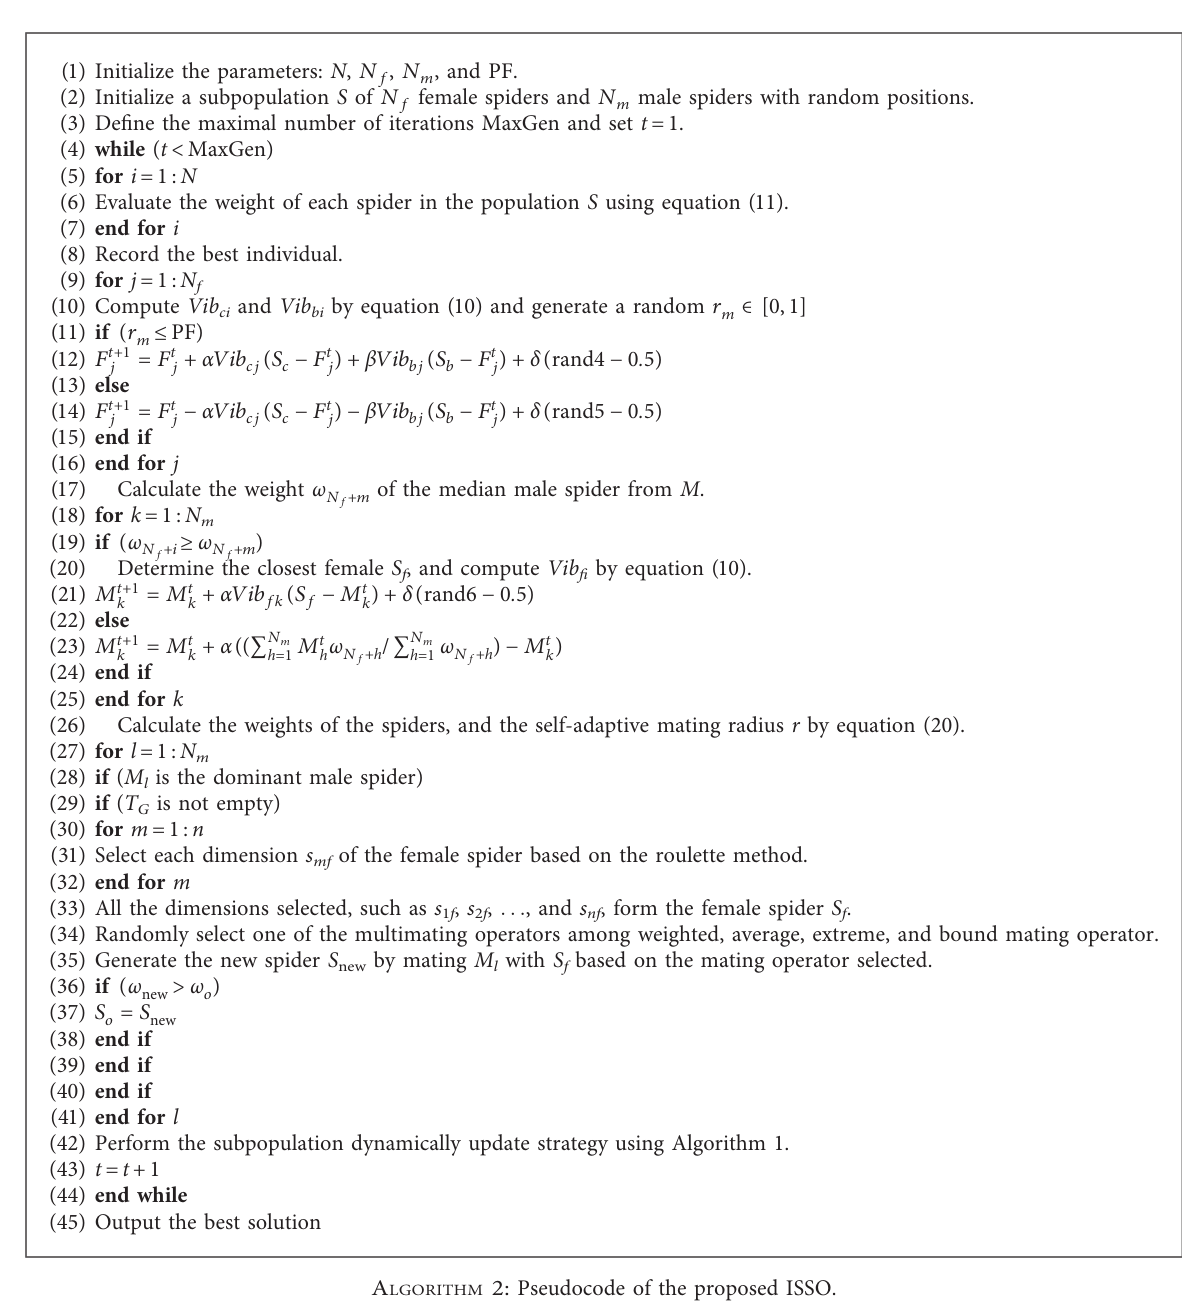
A LGORITHM 2: Pseudocode of the proposed